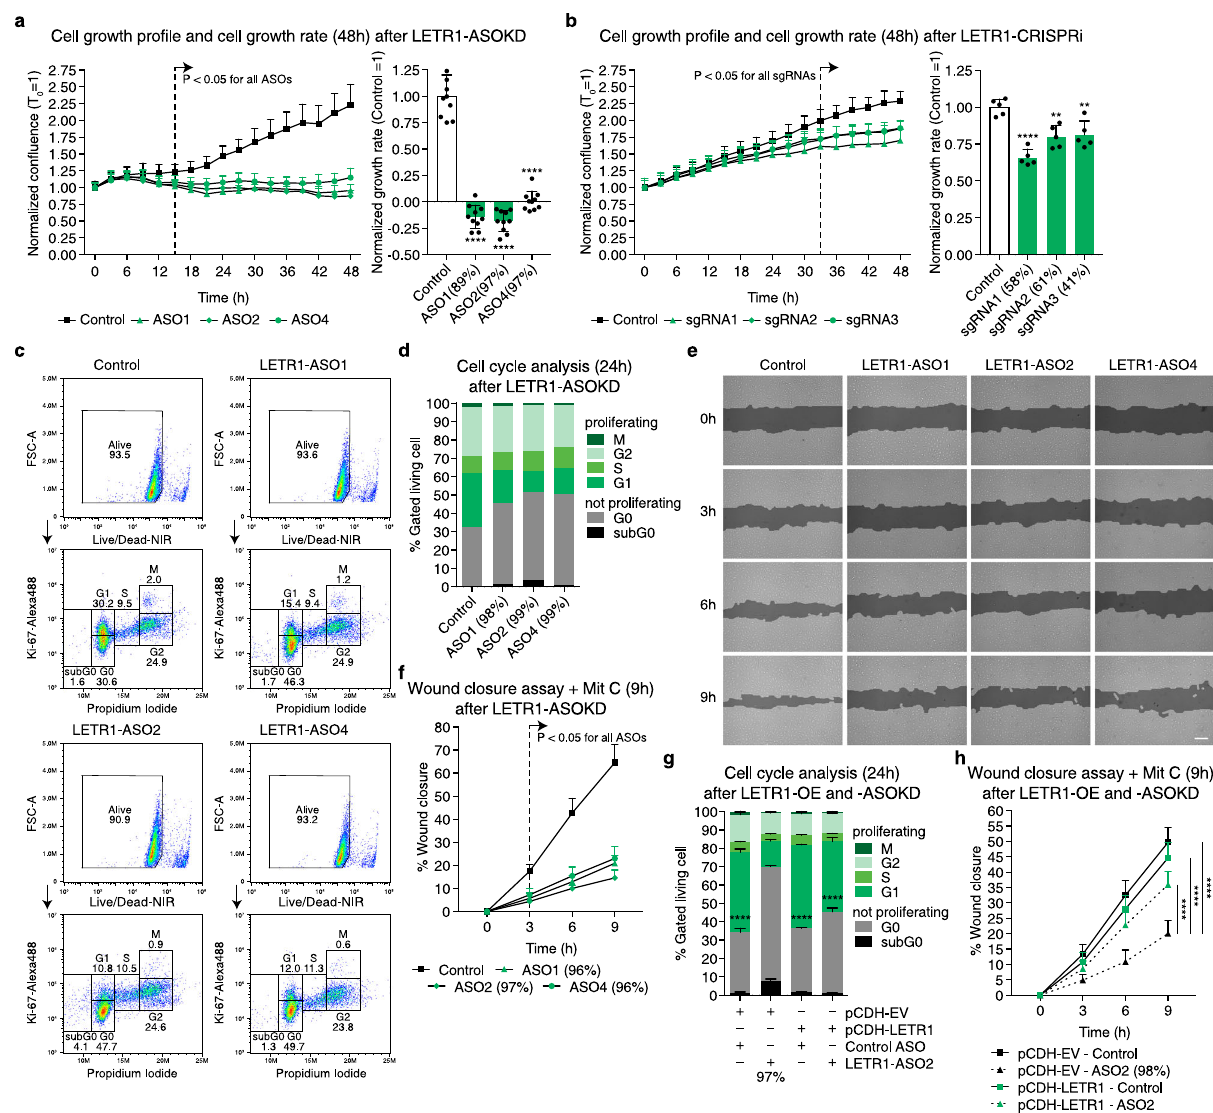
Fig. 5 Knockdown of LETR1 reduces cell growth, cell cycle progression, and migration of LECs in vitro. a , b Cell growth pro fi les and cell growth rates of LECs over 48 h after ASOKD a or CRISPRi-KD b of LETR1 using IncuCyte. Con fl uences were normalized to T 0 . Growth rates were calculated as the slope of linear regression and normalized to scrambled control ASO/sgRNA. c Representative fl ow cytometry plots of LECs after 24 h LETR1-ASOKD. Cells were fi rstly gated with live/dead Zombie staining (upper plots). Resulting living cells were further gated for non-proliferating stages subG0 and G0, and proliferating stages G1, S, G2, and M, using propidium iodide (IP) and Ki-67 (lower plots). d Quanti fi cation of the cell cycle progression analysis of LECs after 24 h LETR1-ASOKD. Bars represent percentages of gated living cells in subG0, G0, G1, S, G2, and M. e Representative images of the wound closure assay (9 h) in LECs after LETR1-ASOKD. Con fl uence mask is shown for all time points. Before scratch, cells were incubated for 2 h with 2 µ g/mL Mitomycin C (proliferation inhibitor) at 37 °C. Scale bar represents 200 µ m. f Quanti fi cation of the wound closure assay (up to 9 h) of LECs after LETR1-ASOKD. g Quanti fi cation of the cell cycle progression analysis of pCDH-empty vector (pCDH-EV) and pCDH-LETR1 infected LECs after 24 h LETR1-ASO2 knockdown. h Quanti fi cation of the wound closure assay (up to 9 h) of pCDH-EV and pCDH-LETR1 infected LECs after LETR1-ASO2 knockdown. Data are displayed as mean values + SD ( n = 10 in a , f , and h ; n = 5 in b ; n = 3 in g ; n = 2 in d ). Percentages represent LETR1 knockdown ef fi ciencies after the experiments. ** P < 0.01, **** P < 0.0001 using ordinary one-way (for a , b , and g ) and two-way (for a , b , f , and h ) ANOVA with Dunnett ’ s multiple comparisons test against scrambled control ASO/sgRNA or LETR1-ASO2 — scrambled control siRNA. In d , g , statistical analysis was performed on G0 populations. In f , h , percentages were determined for each time point using TScratch 109 . All displayed in vitro assays were performed in neonatal LECs derived from the same